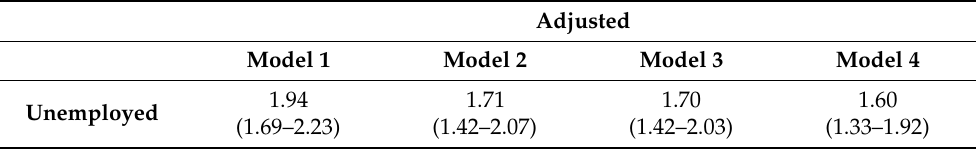
Table 2. Association between all-cause mortality and employment status for Black men in National Health and Nutrition Examination Survey III (n =